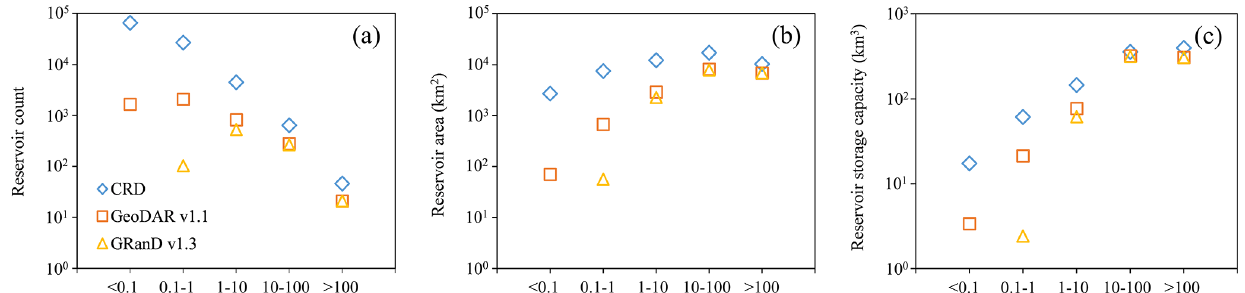
Figure 9. Comparison of reservoirs in count (a) , area (b) , and storage capacity (c) between the CRD database, GeoDAR v1.1, and GRanD v1.3 database with different area